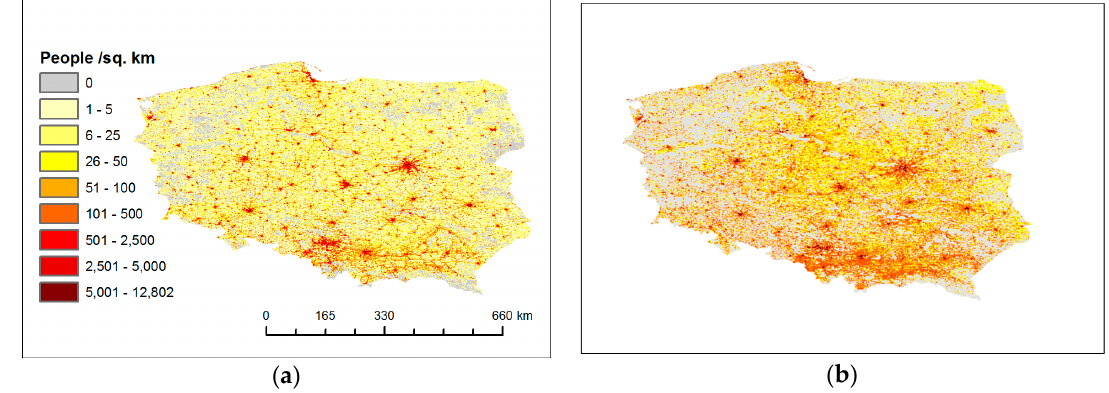
Figure 2. Population distribution by LandScan ( a ) and Polish Population Grid (PPG) ( b ).